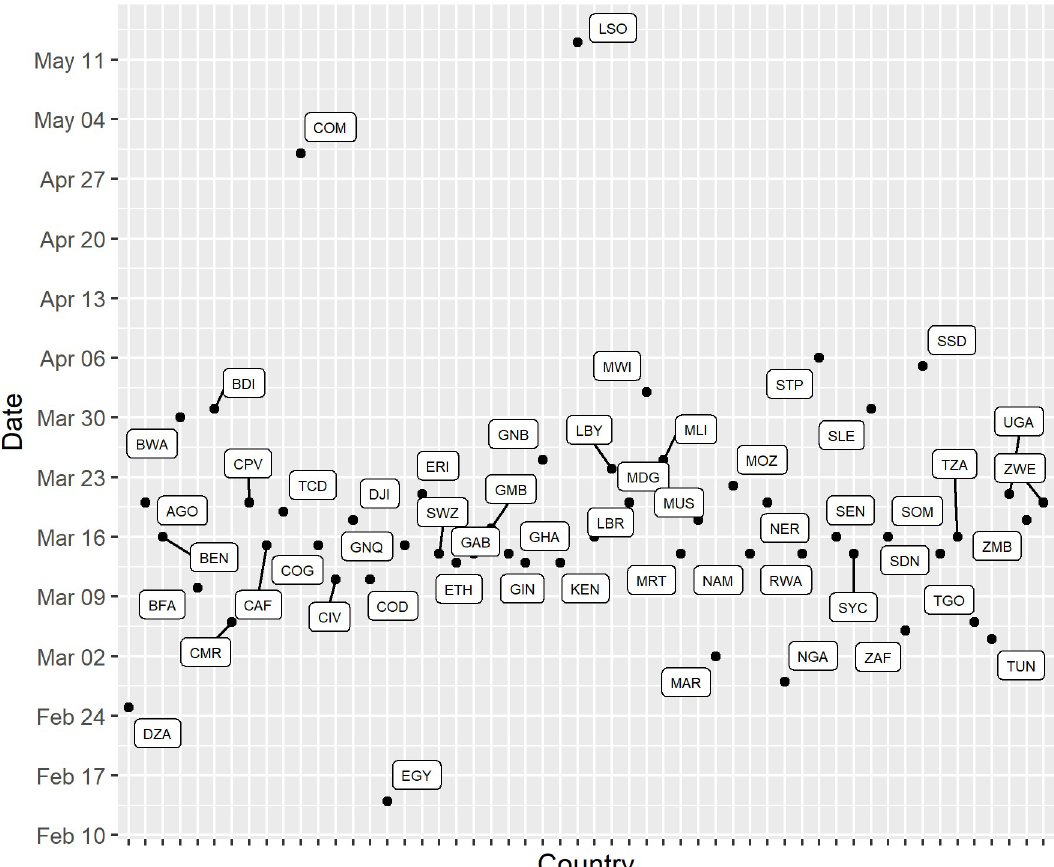
Fig 1. Distribution of the day of the first COVID-19 reported case in 54 African countries. The plot depicts the dates of the first reports of COVID-19 cases in the 54 studied African countries as reported by the Johns Hopkins global time series on the pandemic (CRC, 2020; Dong et al, 2020). The countries in this distribution are designated by their three-letter Alpha-3 codes: DZA: Algeria, AGO: Angola, BEN: Benin, BWA: Botswana, BFA: Burkina Faso, BDI: Burundi, CPV: Cabo Verde, CMR: Cameroon, CAF: Central African Republic, TCD: Chad, COM: Comoros, COD: Democratic Republic of the Congo, COG: Congo, CIV: Coˆte d’Ivoire, DJI: Djibouti, EGY: Egypt, GNQ: Equatorial Guinea, ERI: Eritrea, SWZ: Eswatini, ETH: Ethiopia, GAB: Gabon, GMB: Gambia, GHA: Ghana, GIN: Guinea, GNB: Guinea-Bissau, KEN: Kenya, LSO: Lesotho, LBR: Liberia, LBY: Libya, MDG: Madagascar, MWI: Malawi, MLI: Mali, MRT: Mauritania, MUS: Mauritius, MAR: Morocco, MOZ: Mozambique, NAM: Namibia, NER: Niger, NGA: Nigeria, RWA: Rwanda, STP: Sao Tome and Principe, SEN: Senegal, SYC: Seychelles, SLE: Sierra Leone, SOM: Somalia, ZAF: South Africa, SSD: South Sudan, SDN: Sudan, TZA: United Republic of Tanzania, TGO: Togo, TUN: Tunisia, UGA: Uganda, ZMB: Zambia, ZWE: